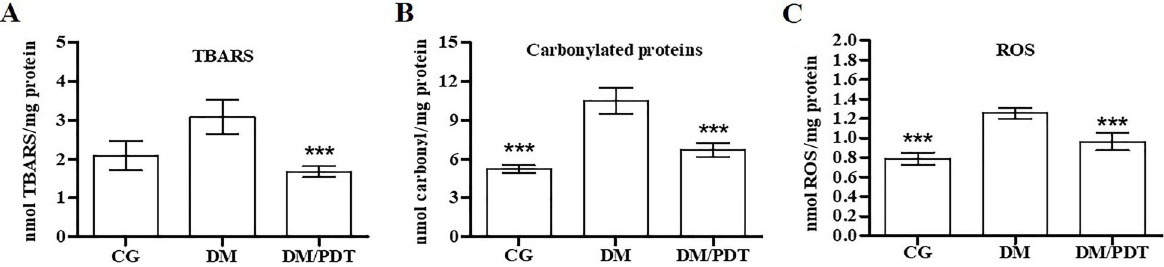
Figure 5. Hepatic oxidative stress of Wistar rats after 14 days of oral administration of chlorophyll-based extract (CBE; 22 mg/L). Levels of thiobarbituric acid reactive substances (TBARS) ( A ) and carbonylated proteins ( B ) in liver total homogenate, and reactive oxygen species (ROS) ( C ) in the supernatant of total liver homogenate after 1 h of infusion with KH buffer of fed Wistar rats. CG: control animals without light irradiation; DM: type 1 diabetic animals without light irradiation; DM/PDT: diabetic animals with light irradiation. Data reported as means ± SD, n=5/group. ***P o 0.05 vs DM (one-way